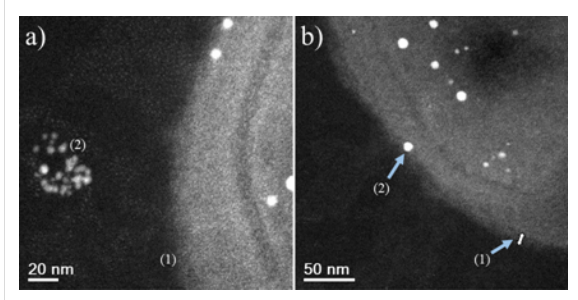
Figure 6: MSSA STEM micrographs. (a,b) (1) WTAs and CWGs ( ≈ 3 nm). (2) Interactions between AgNPs and a cell wall. The Ag nanoparticle concentration is 23 ppm.